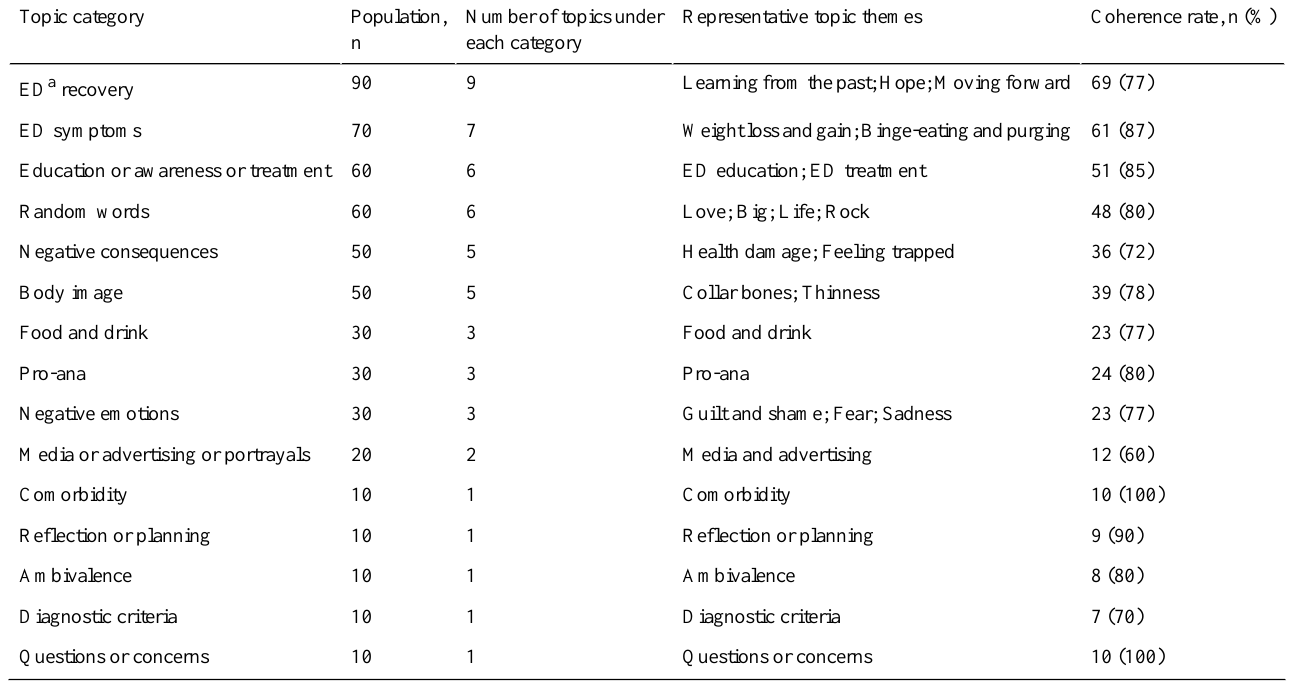
Table 2. A summary of the topics using group 1 tweets (ie, manually identified ED-laypeople tweets).